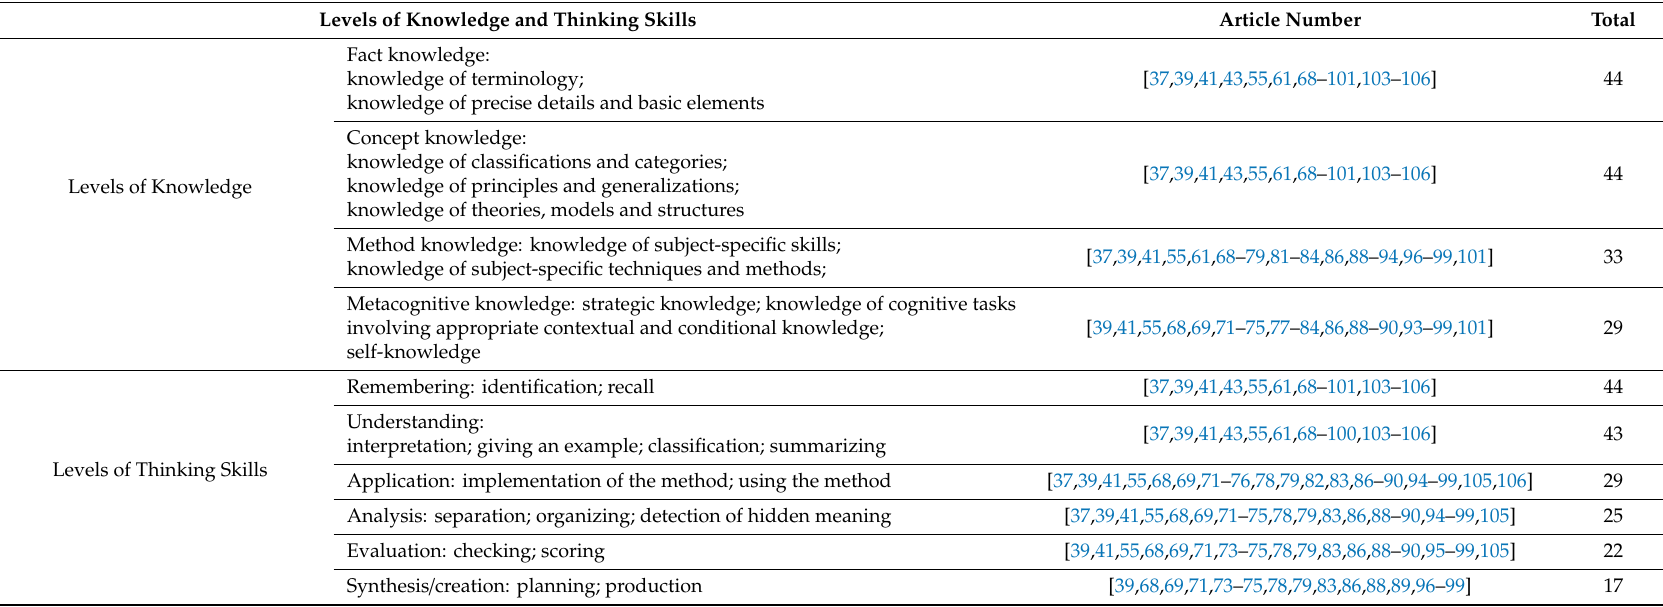
Table 5. The levels of knowledge skills [122,123] and thinking skills [124] in the 45 articles analyzed. Levels of Knowledge and Thinking